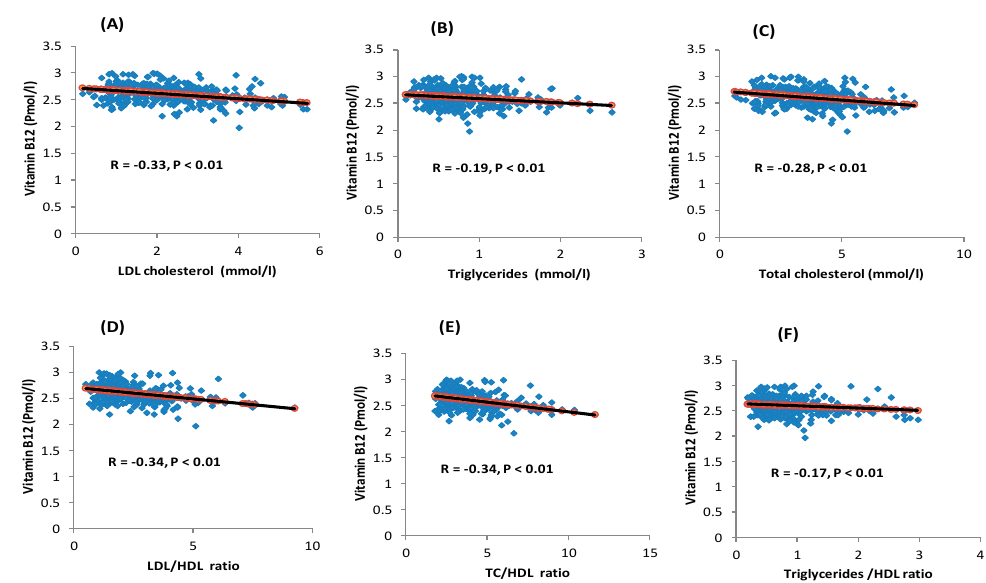
Figure 2. Associations between serum vitamin B12 levels and lipid parameters. ( A ) Association between serum vitamin B12 levels and LDL-C; ( B ) Association between serum vitamin B12 levels and triglycerides; ( C ) Association between serum vitamin B12 levels and total cholesterol; ( D ) Association between serum vitamin B12 levels and LDL / HDL ratio; ( E ) Association between serum vitamin B12 levels and TC / HDL ratio; and ( F ) Association between serum vitamin B12 levels and Triglyceride / HDL ratio. Note: the p -value was obtained from the Pearson correlation test. Table 2. Associations between vitamin B12 and lipid profile per 1 SD vitamin B12; n = 341. Parameters